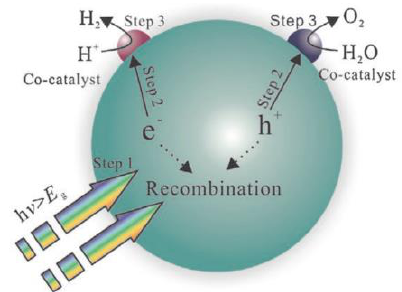
Figure 5. The three typical steps of photoelectrochemical (PEC) water splitting.